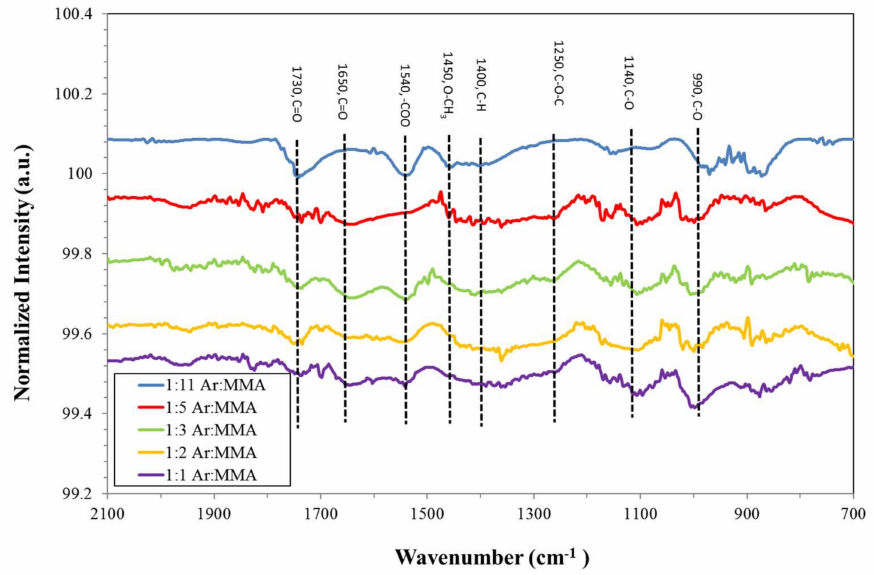
Figure 7. The FTIR spectra for PP-MMA films deposited with the variation in Ar/MMA volume ratios.